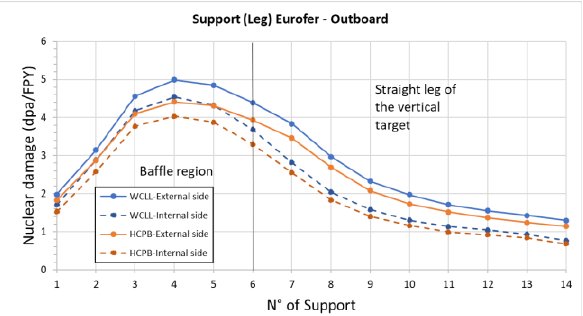
Figure 47. Outer poloidal profiles of the nuclear damage (dpa/FPY) on PFC-CB supports made of Eurofer, comparing the values on the external and innermost target sides, both for WCLL and HCPB blanket case.